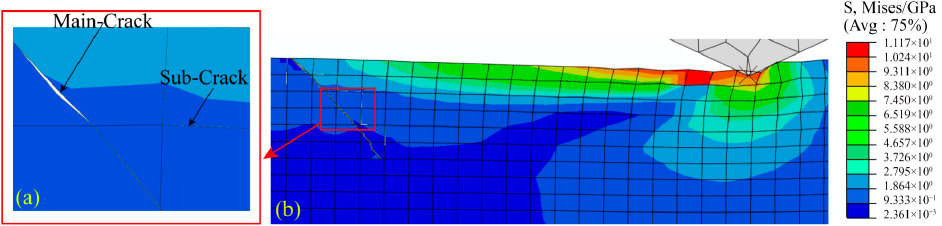
Figure 6. Stress nephogram of the CrN-3Pt coating when the crack propagates to half of the coating thickness: ( a ) Crack enlargement, ( b ) State of crack.